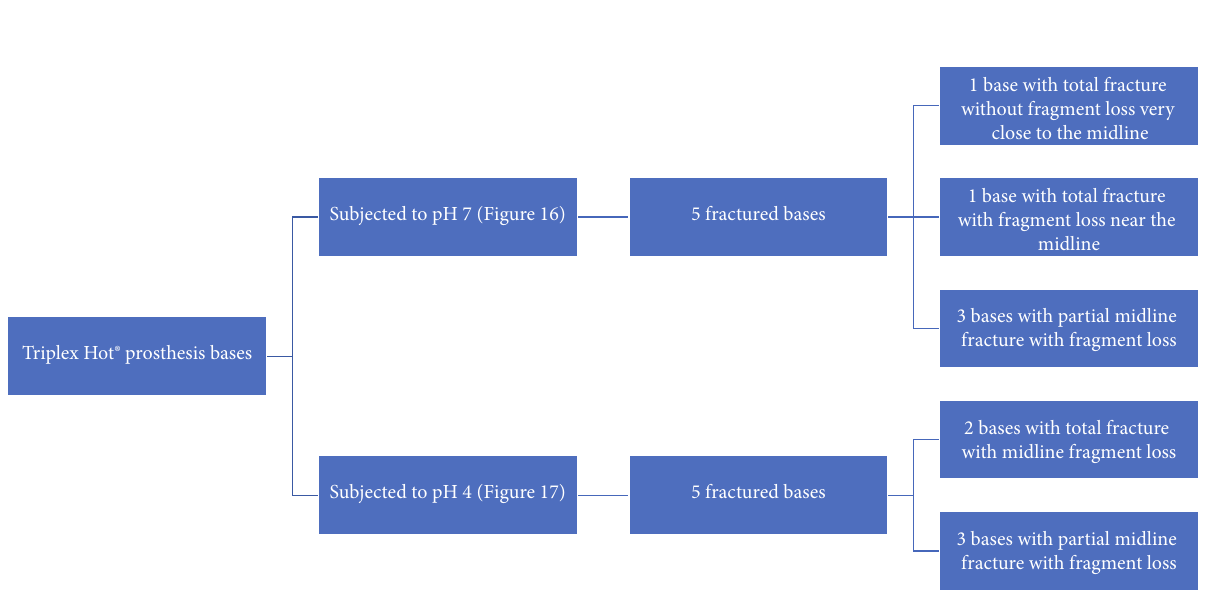
Figure 12: Observations concerning the fracture resistance performance of the acrylic Triplex Hot ®